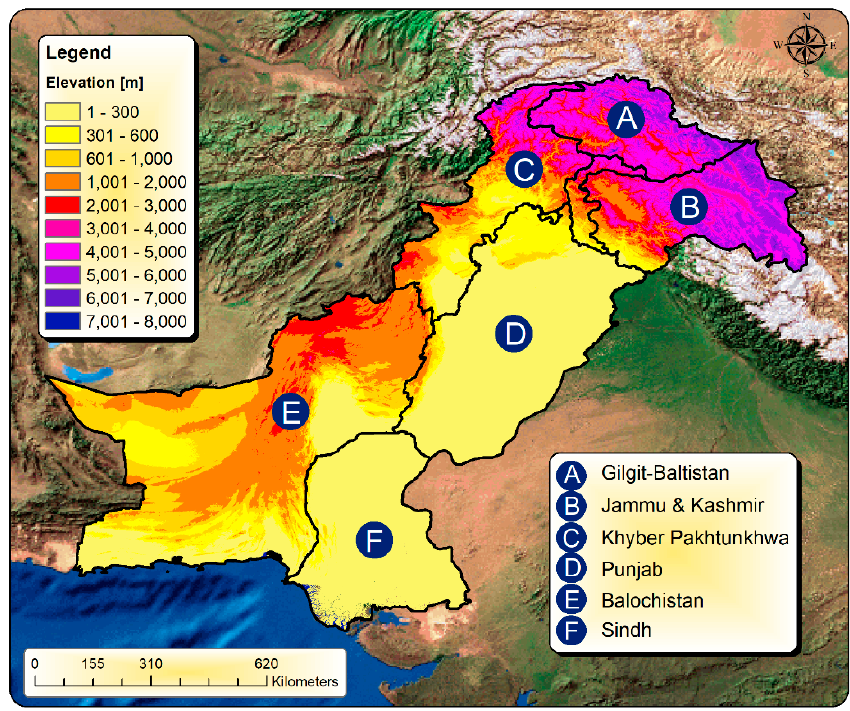
Figure 1. Geographical locations of Pakistan. The color variations represent elevation.